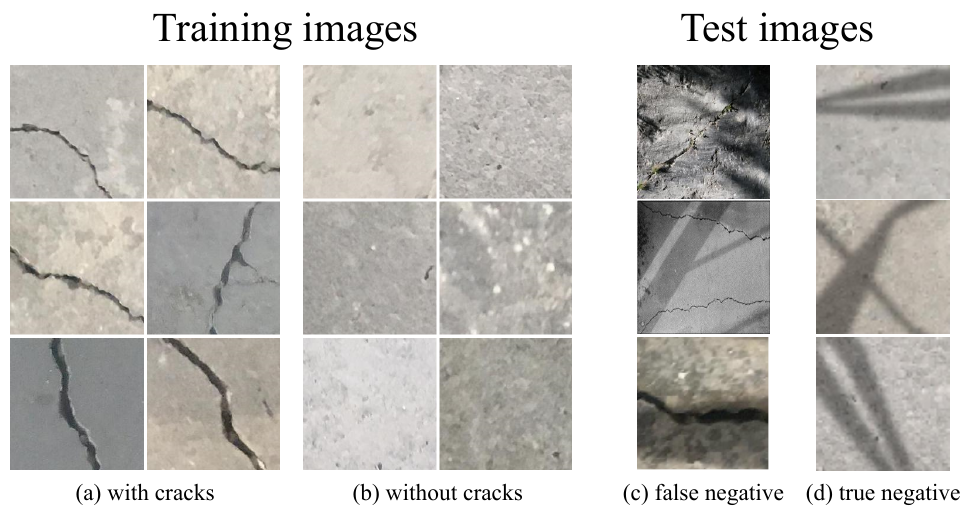
Figure 5. Examples of the wrong classification of concrete images with shadows. Training images with and without cracks are displayed in the parts ( a , b ), respectively; incorrectly and correctly predicted images without cracks are presented in the parts ( c , d ), respectively.